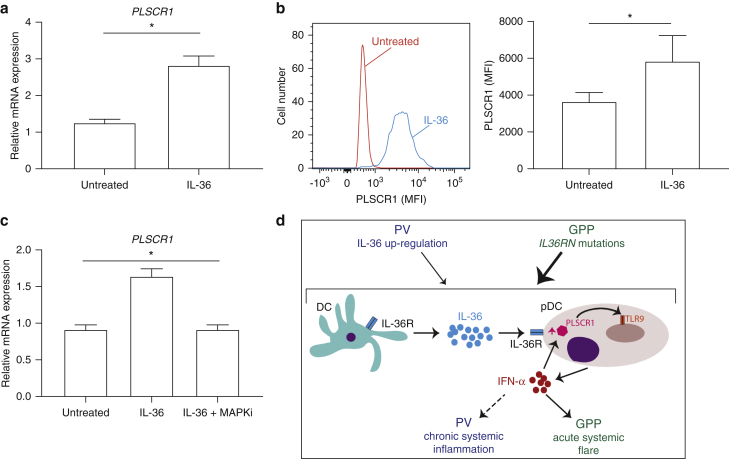
IL-36 upregulates PLSCR1. (a) After treatment of PBMCs with IL-36, PLSCR1 expression was measured by real-time PCR. (b) After IL-36 treatment of pDCs, PLSCR1 MFI was measured by flow cytometry, in gated PSLCR1+ pDCs. A representative histogram is shown on the left. (c) After pretreatment with SB203580 (MAPKi), PBMCs were stimulated with IL-36. PLSCR1 expression was then determined by real-time PCR. (d) Proposed pathogenic model. IL-36 produced by mDC upregulates PLSCR1 in pDCs, potentiating TLR-9 dependent IFN-α release. IFN-α induces further PLSCR1 transcription, thus propagating an inflammatory feed-forward loop. All data are shown as mean ± SEM of results obtained in at least three donors, each stimulated in triplicate. *P < 0.05 (Wilcoxon signed rank test [a, b] and Friedman test with Dunn posttest [c]) mDC, myeloid dendritic cell; MFI, mean fluorescence intensity; PBMC, peripheral blood mononuclear cell; pDC, plasmacytoid dendritic cell; TLR, toll-like receptor; SEM, standard error of the mean.